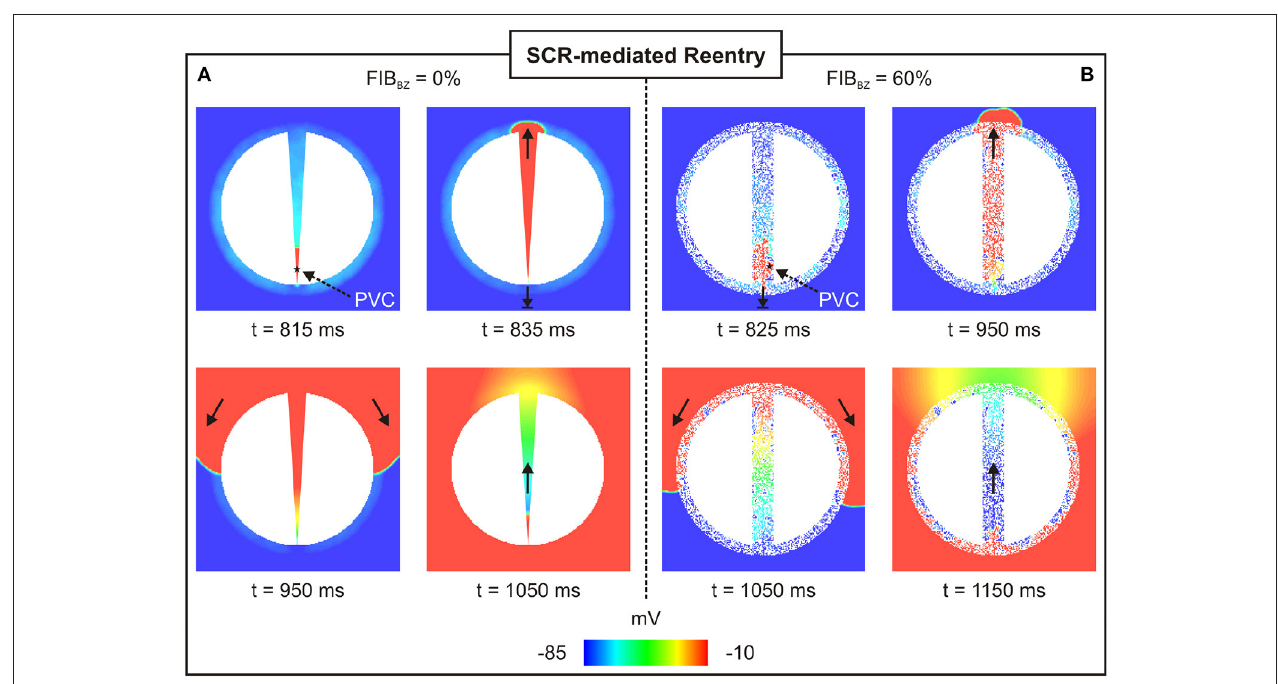
FIGURE 10 | Arrhythmia induced by a SCR-mediated PVC. Reentry induced by a PVC in a (A) 2D sheet with w isth progressively widening from 0.2mm (proximal to the stimulus) to 4mm (distal mouth); and (B) 2D sheet with w isth = 4mm and FIB BZ = 60%. V m maps at different times showing PVCs triggered near the proximal mouth. Bold arrows depict successful propagation as well as unidirectional conduction block.